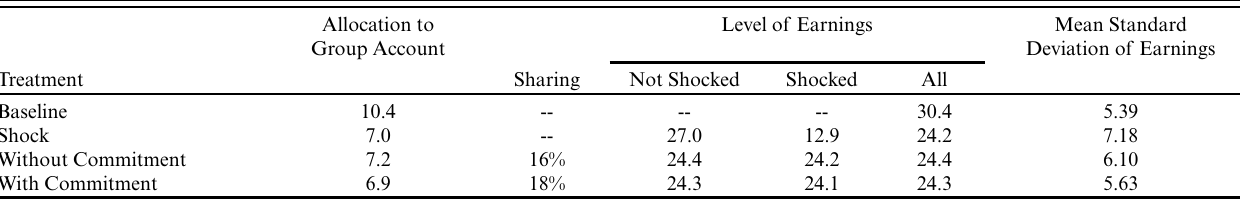
Table 2 . Mean individual decisions and earnings.